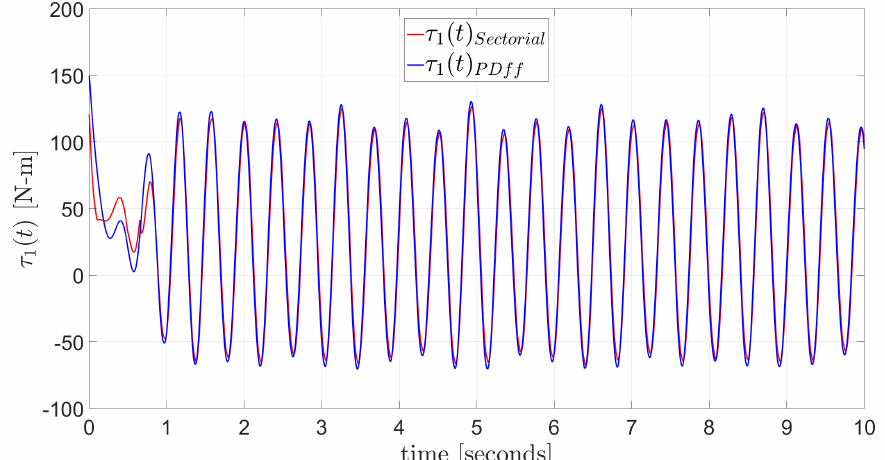
Figure 23. Applied torque to joint 1.